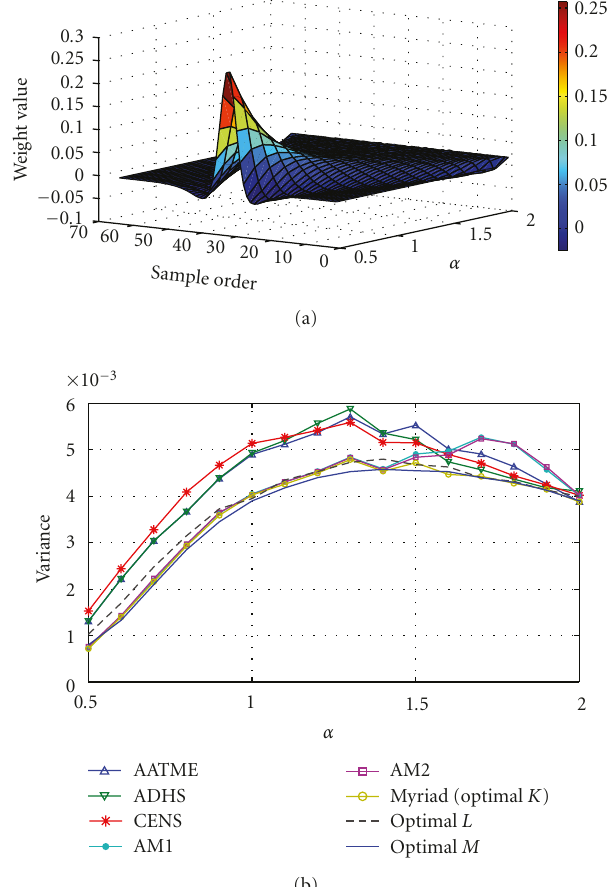
Figure 12: Optimal weights for L-estimator ( N = 64) (a) and variance values of LP estimation for the considered adaptive and optimal estimators ( N = 512) (b) for the S α S processes ( γ =